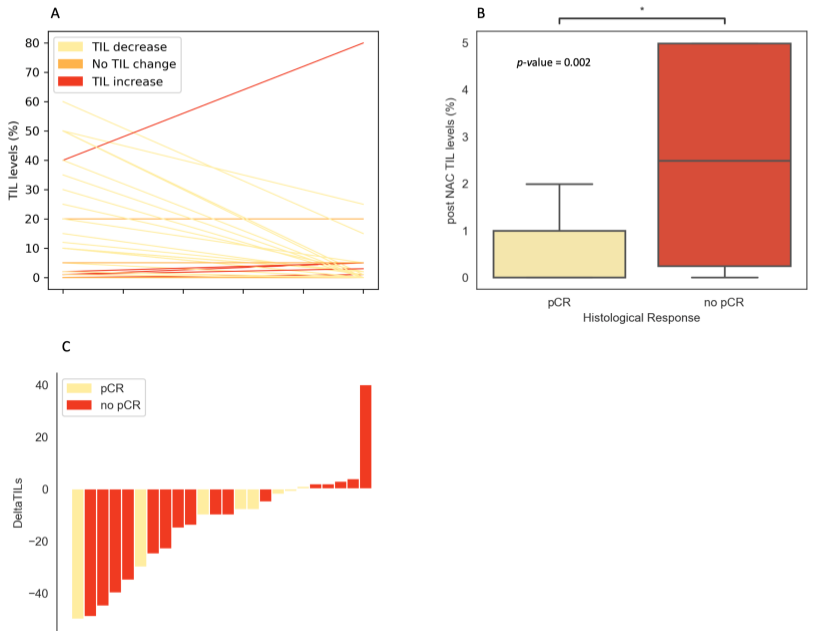
Figure 2. ( A ) Variation of TIL levels. Lines represent pre- and post-NAC paired TIL level values of a given patient and are colored according to TIL variation category (TIL level decrease: yellow / no change: orange / increase: red). ( B ) * Bar plots of post-NAC TIL levels according to pCR status; p = 0.02. ( C ) Waterfall plot representing the variation of TIL levels according to pCR status. We removed the samples with no variation from the